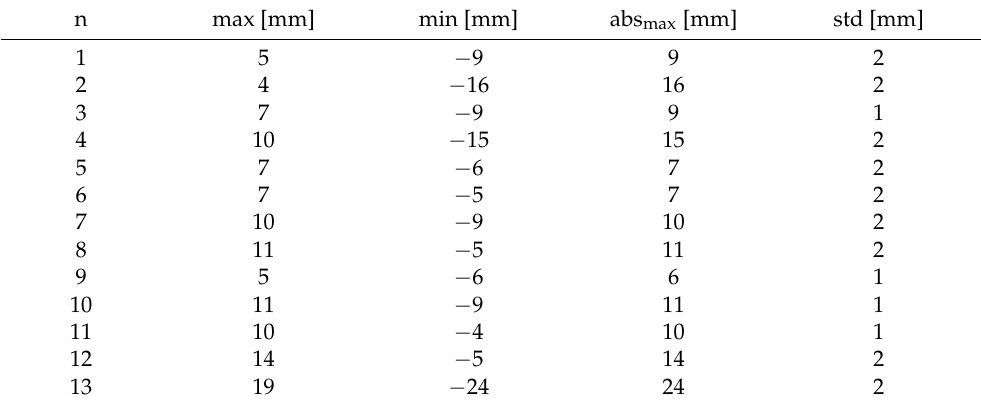
Table 3. Quantification of flatness of the